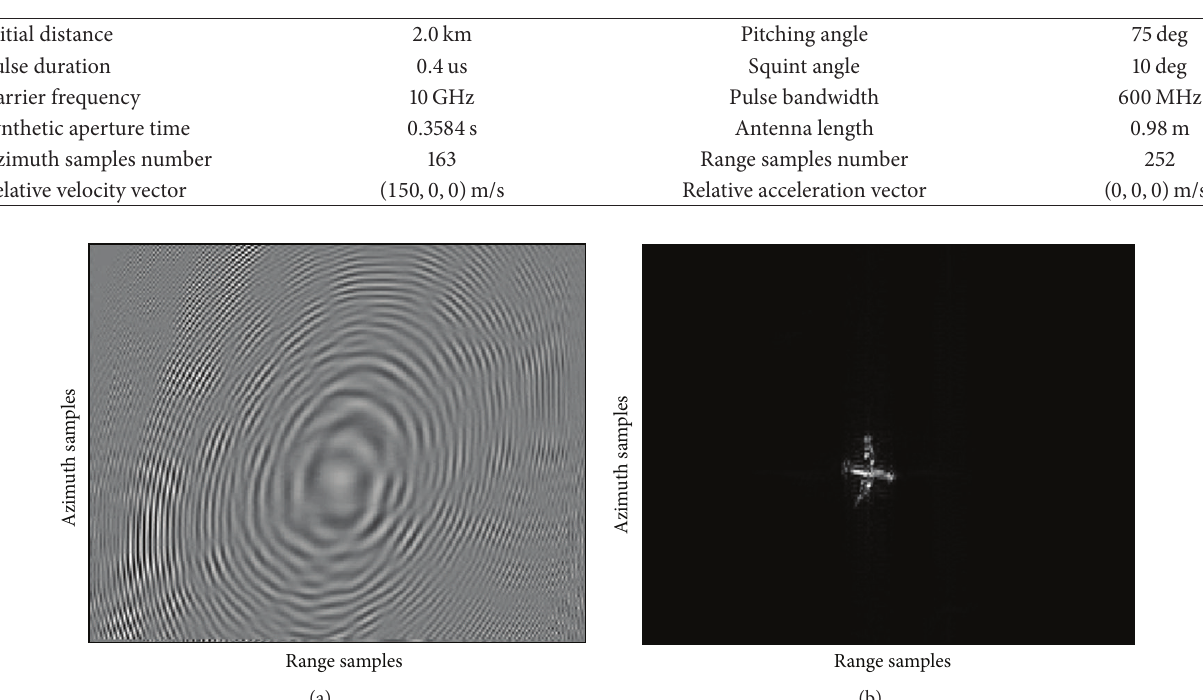
Figure 10: The simulated echo (a) and image (b) results of the plane model in the case of uniform linear motion.